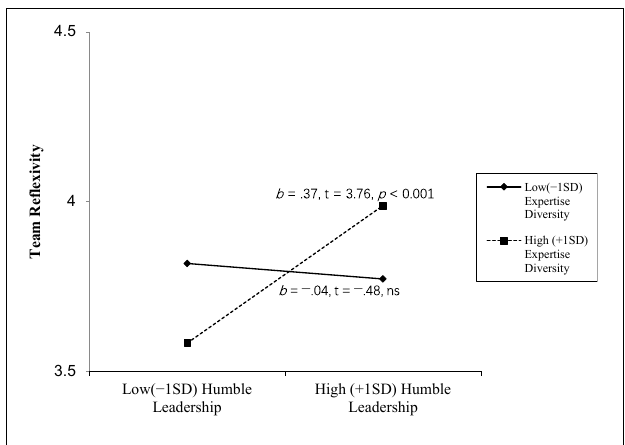
FIGURE 2 | Moderating effect of team expertise